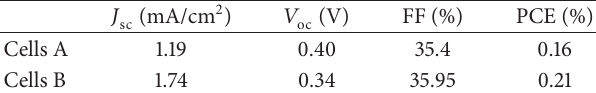
Table 1: Key parameters of two kinds of OPVs under 100 mW/cm 2 illumination intensity.